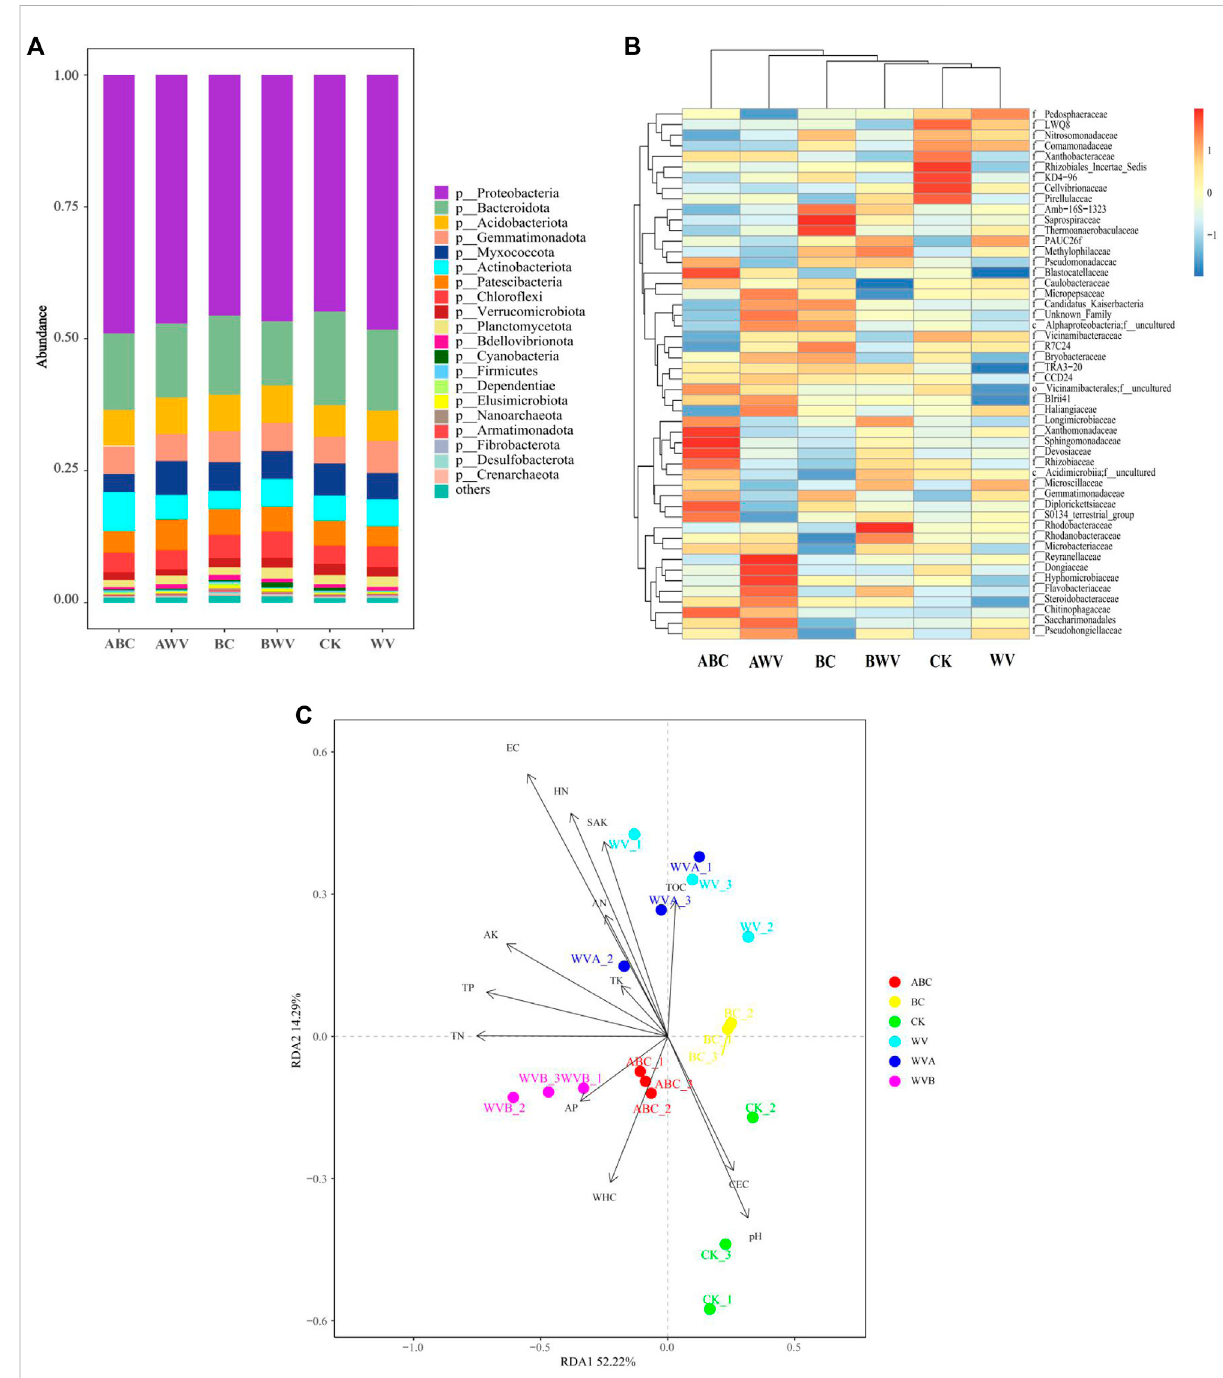
FIGURE 5 Relative abundance of the top 10 bacterial phyla in the coastal saline − alkali soil and the heat map of the top 35 bacteria at the family level (A) . Colorintensityofthescaledemonstratestherelativeabundanceofeachgenus (B) .Redundancyanalysis(RDA) betweenthemicrobialfamilyrelative abundance and soil properties in different treatments (C)